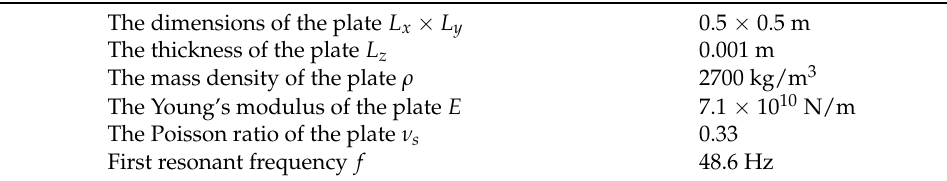
Figure 4. Photo of the hardware-in-the-loop experiment platform. Table 1. Values of model